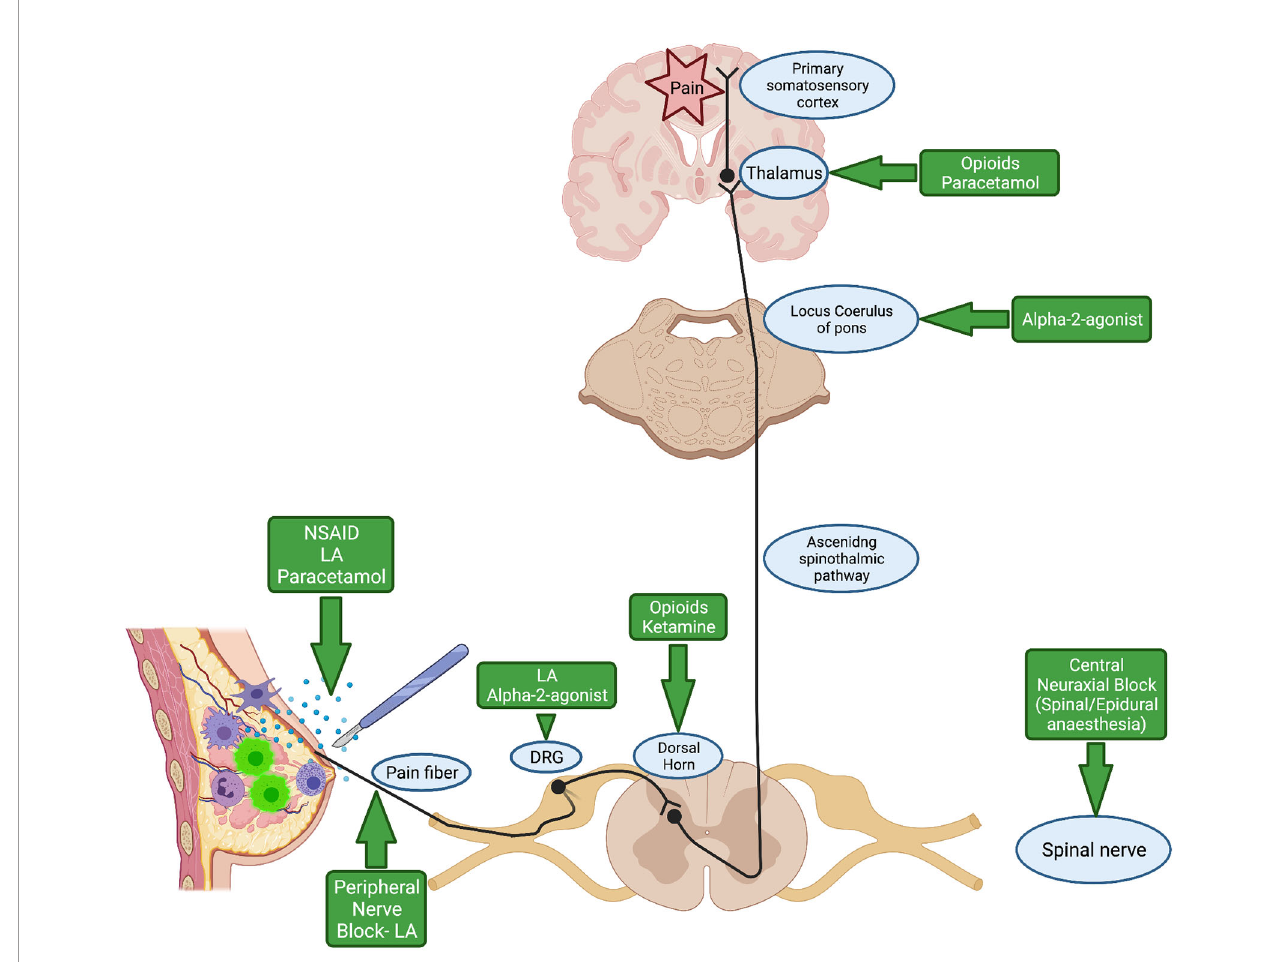
FIGURE 2 | Pain pathway and site of action of commonly used analgesic agents during the perioperative period. NSAID, Non-steroidal anti-in fl ammatory drug; LA, Local Anaesthetic; DRG, Dorsal Root Ganglion. Created with